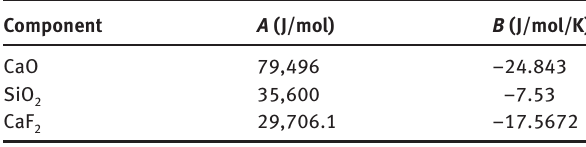
Table 1: Values of Gibbs free energy of fusion ( θ ∆ = + fus G A BT )